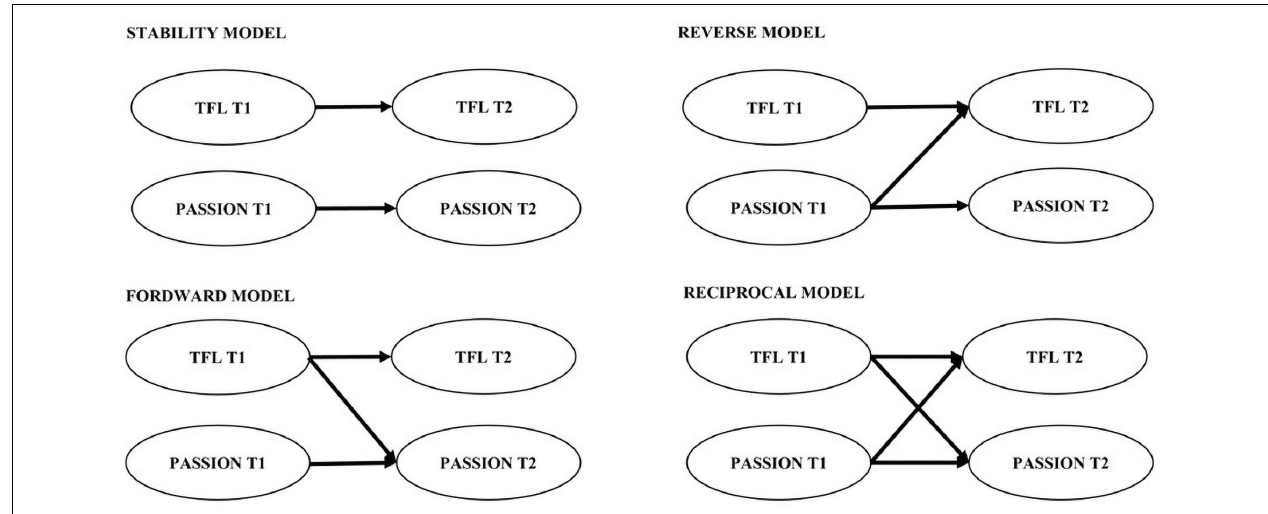
FIGURE 1 | Simplified example of step 1 models. This is an example of the step 1 models, step 2 models follow the same structure. TFL, Transformational leadership.